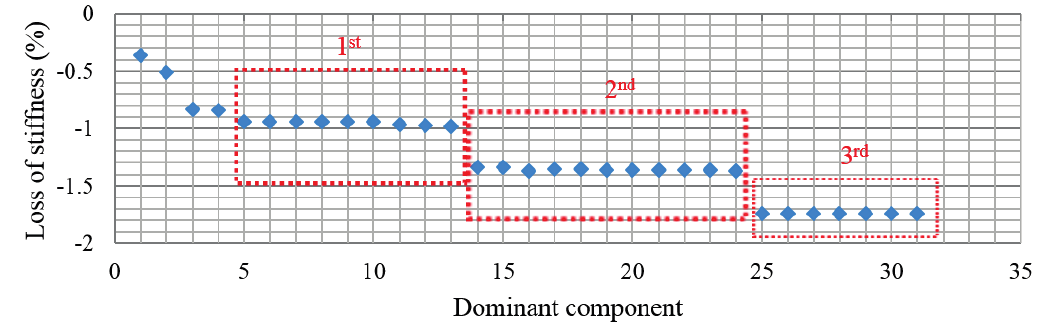
Figure 17. Loss of stiffness identification in each dominant component in Case 1.